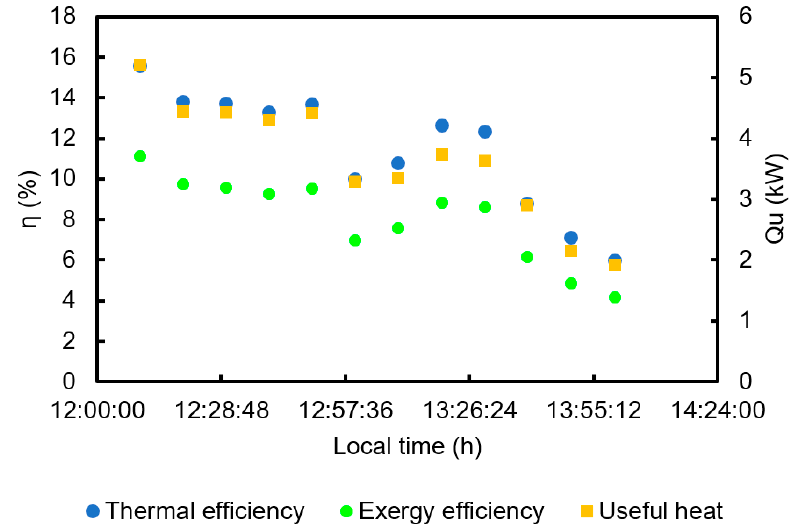
Figure 9. Thermal efficiency, exergy efficiency, and useful heat, 5 December 2017.